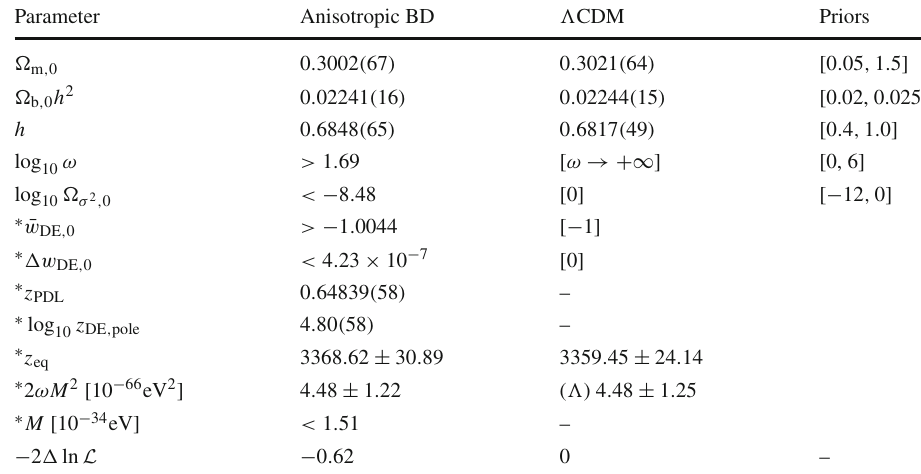
Table 1 Constraints on the anisotropic Brans–Dicke extension of the standard (cid:2) CDM model using the combined data sets PLK+BAO+SN+ H . For two-tailed distributions, the results are given in 1 σ and for one-tailed distributions, the results are given in 2 σ . (cid:2) CDM column corresponds to GR limit (Brans–Dicke gravity with ω → ∞ ) and the shear scalar σ 2 = 0 (isotropic). Parameters and ranges of the uniform priors assumed in our analysis and derived parameters are labeled with ∗